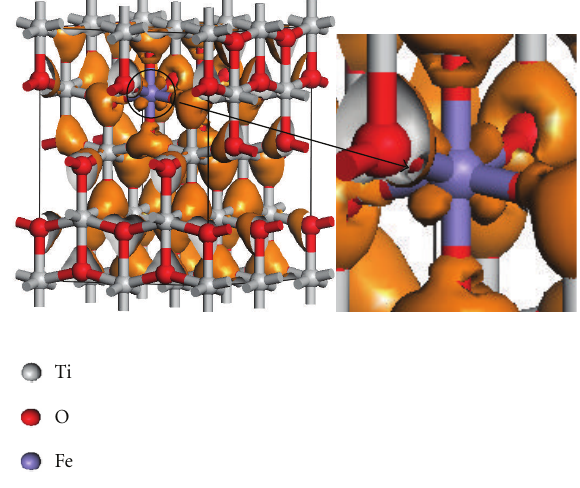
Figure 4: Charge distribution of Fe-doped TiO 2 .